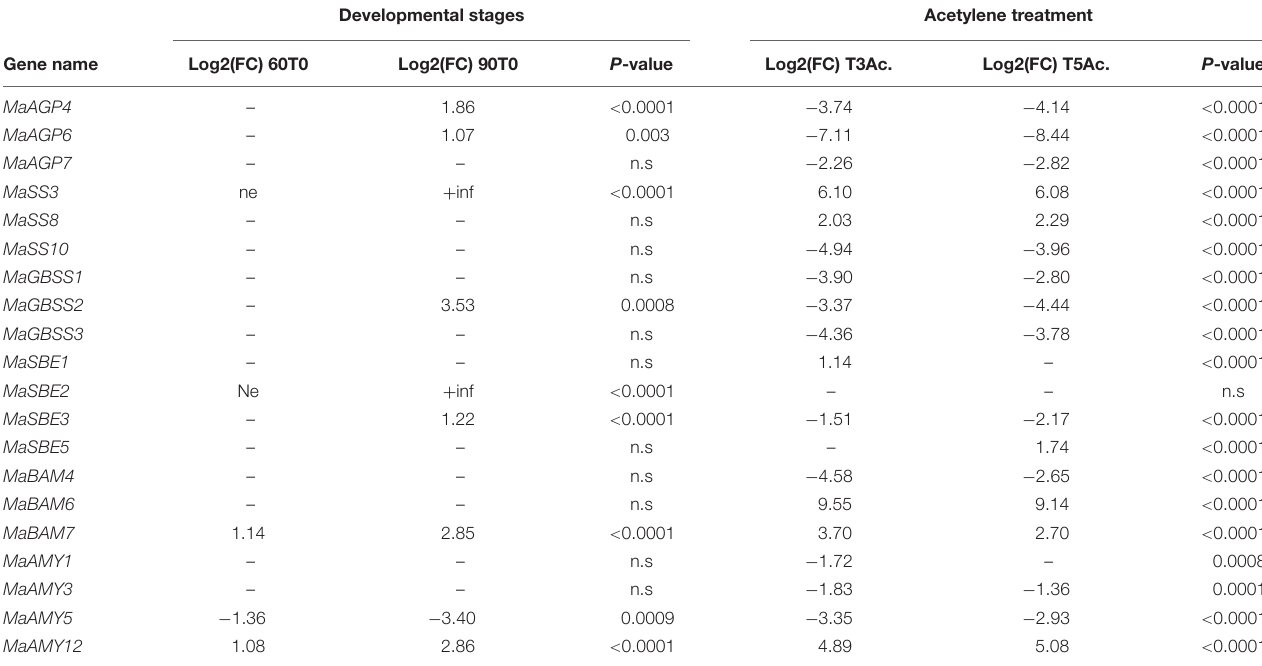
TABLE 1 | Differential expression of starch metabolism genes in banana